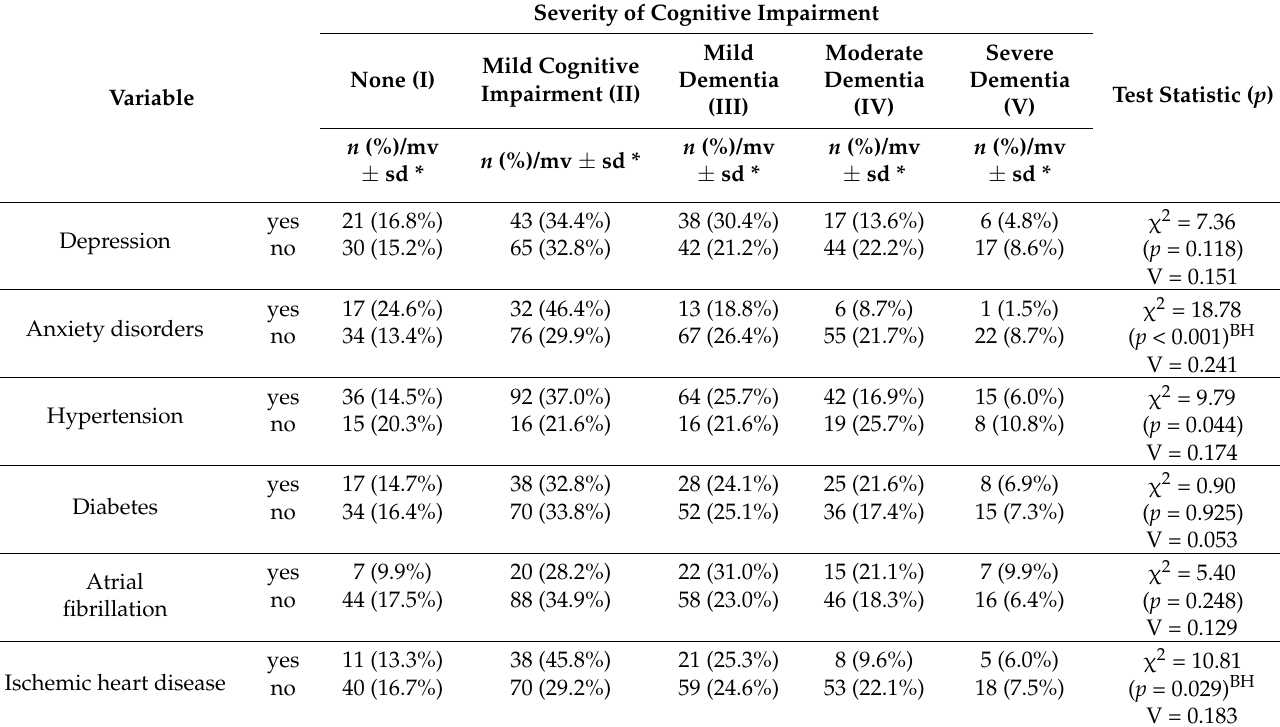
Table 3. Associations between occurrence of comorbidities and severity of cognitive